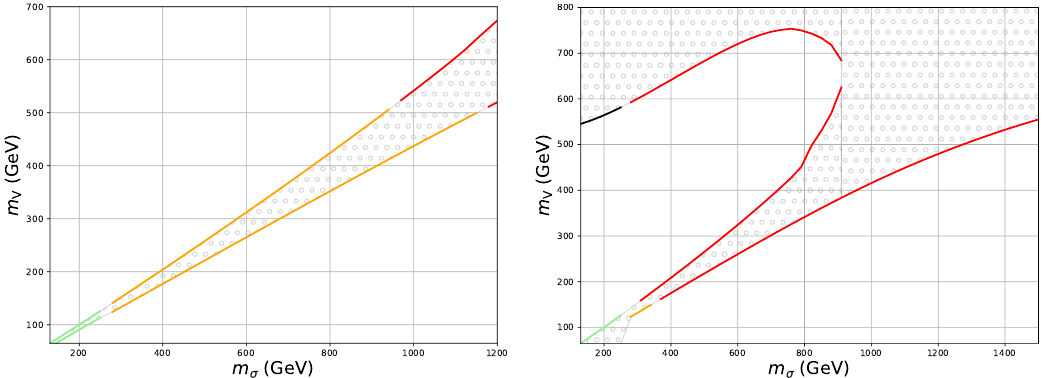
Figure 8 . Combined dark matter and Higgs constraints for sin (cid:11) = 0 : 11 (left panel) and 0.15 (right panel) for a ‘gauge invariant’ treatment of the Higgs-dilaton mixing. The description is similar as in (cid:12)gure 7, except that there are no LHC or HL-LHC constraints from monojets or multijet searches, the cross sections being orders of magnitude too